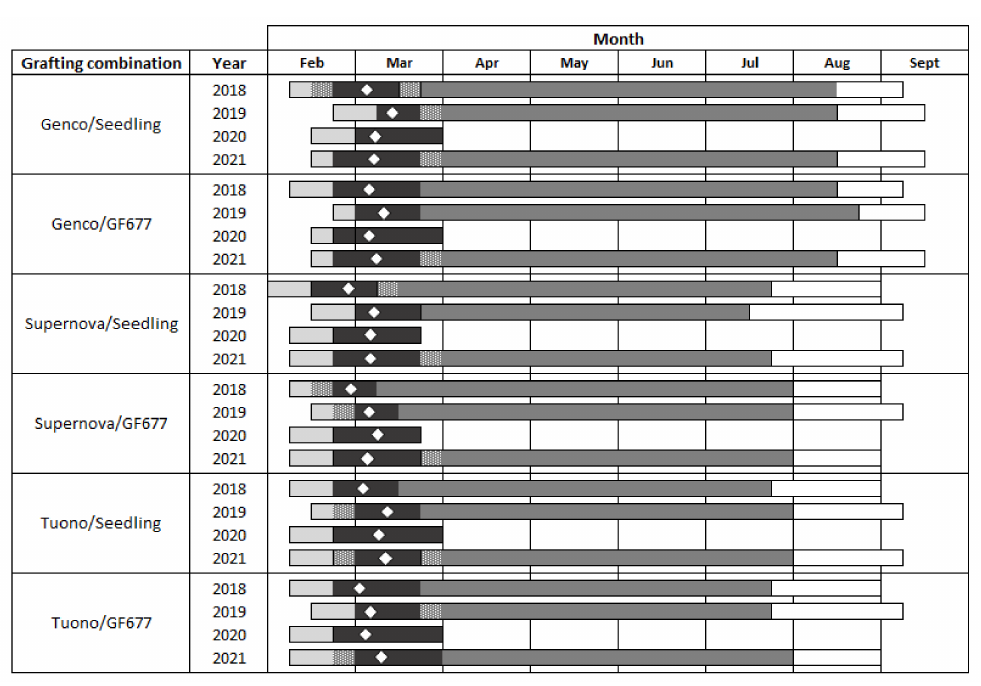
Figure 1. Phenograms of blooming and ripening recorded over four years of investigation (2018–2021) for cultivars ‘Genco’, ‘Supernova’ and ‘Tuono’ grafted on clonal rootstock ‘GF677’ and seedling rootstocks, respectively (light grey histogram = beginning flowers emergence; dark grey histogram = blooming; white dots = overlapping of successive phenological stages; mid- dark grey histogram = fruit development; white histogram = fruit maturity: 1% hull